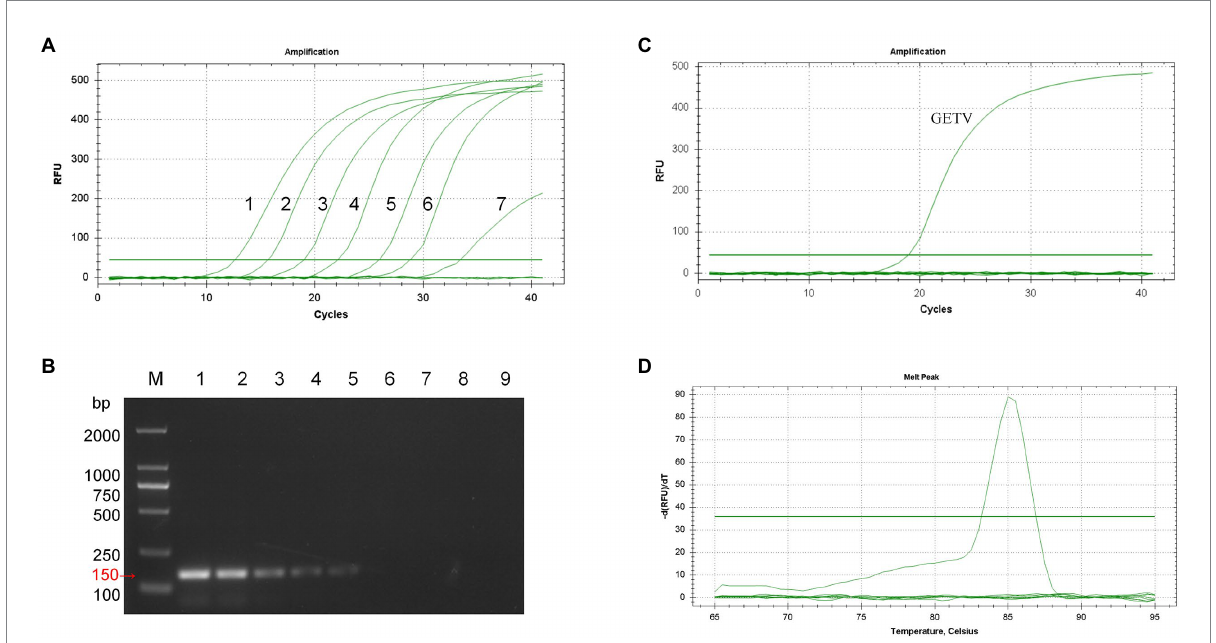
FIGURE 2 Sensitivity and specificity analysis of SYBR Green I RT-qPCR for GETV. (A) Amplification curve. 1–7: 7.73 × 10 6 PFU/mL–7.73 × 10 − 0 PFU/mL. (B) Conventional PCR sensitivity detection. M: DL2000 marker; 1–8: 7.73 × 10 6 PFU/mL–7.73 × 10 –1 PFU/mL; 9: non-template-control. (C) Only GETV had an amplification curve. JEV, PRRSV, AKAV, EIV, SINV, ZIKV, and negative controls had no fluorescence signal amplification. (D) Only GETV had a specific melting peak at 85.5 ± 0.5 ° C, with no non-specific products.